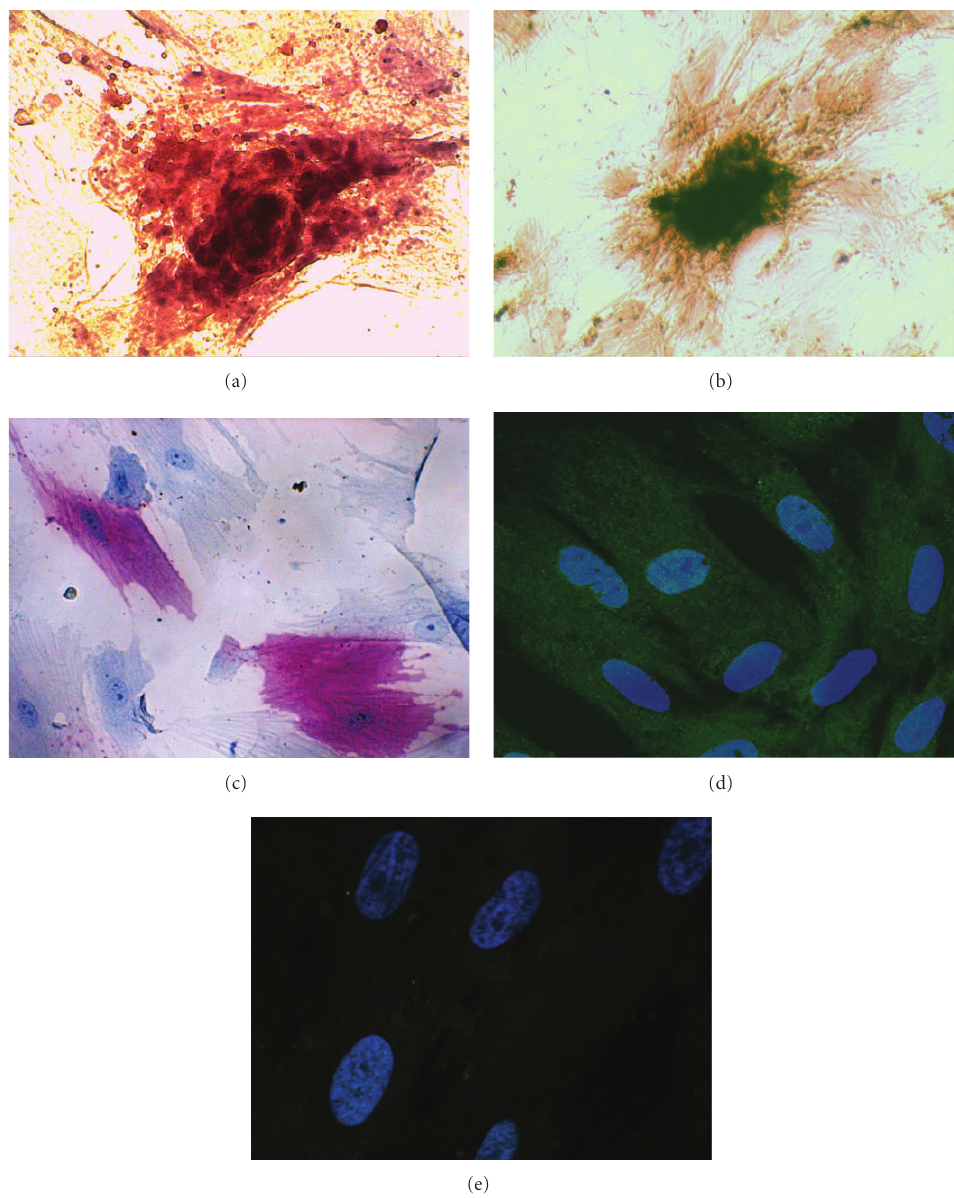
Figure 4: Osteogenic di ff erentiation. Alizarin red staining revealing formation of calcium deposition in UC-MSCs (a) and in human BM- MSCs (b); (c) alcaline phosphatase cytoenzymatic staining of UC-MSCs; immunofluorescence for osteocalcin in UC-MSCs cultured in osteogenic medium; (d) osteocalcin stained with primary antibody against and with a secondary antibody anti-mouse (conjugated with Alexa Fluor 488) and merged with DAPI (blue, nuclei), (e) negative control with DAPI and secondary antibody